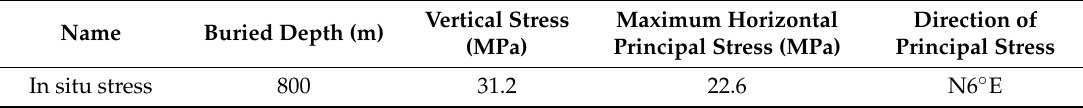
Table 1. Results of geostress measurement.